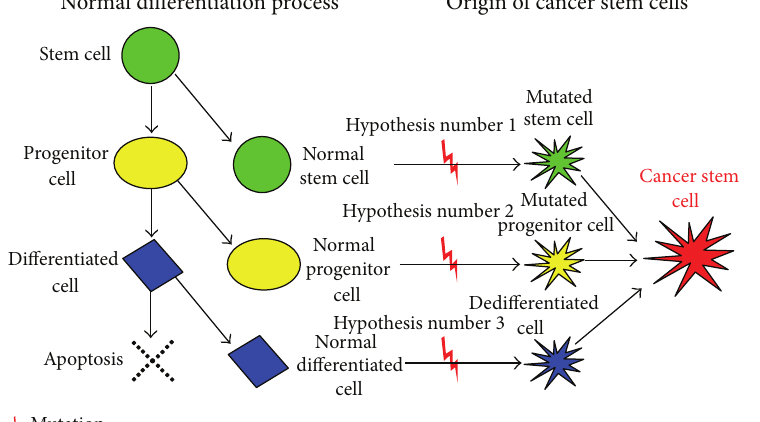
Figure 1: Hypothesis suggesting origin of cancer stem cells. In the process of normal differentiation a cell differentiates to form two cells, differentiated and primitive. A terminally differentiated cell is formed from precursor progenitor cell and finally undergoes apoptosis. CSC may originate from a normal stem cell (Hypothesis number 1), a normal progenitor cell (Hypothesis number 2), or a normal differentiated cell (Hypothesis number 3) by genetic mutation which will activate self-renewal genes.